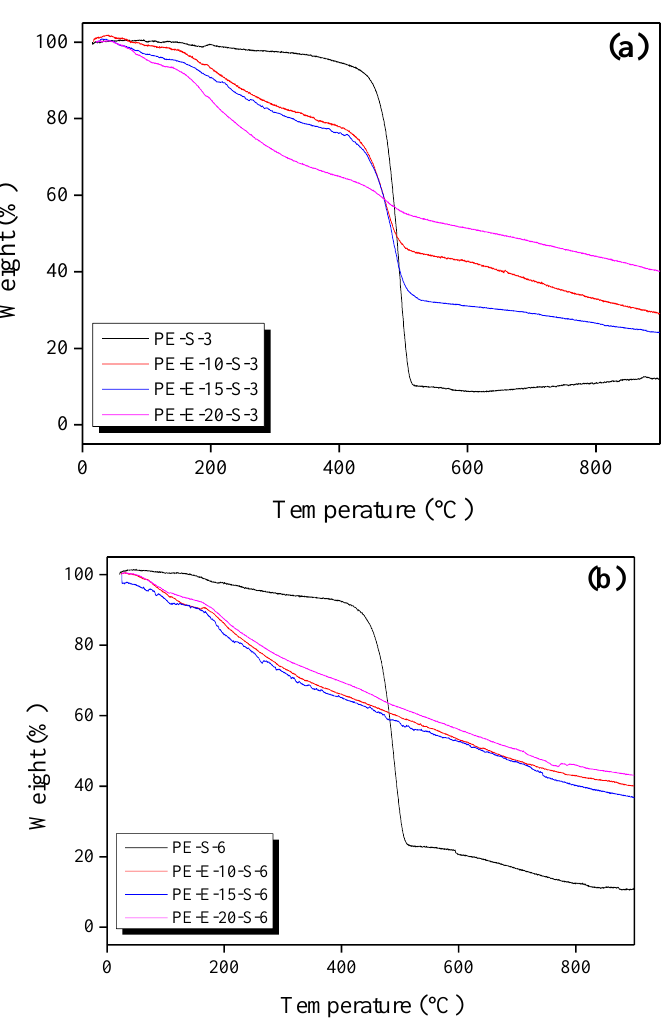
Figure 5. TGA graphs of E-beam and sulfuric acid treated LLDPE fibers: ( a ) sulfuric acid 30 min, ( b ) sulfuric acid 60 min.